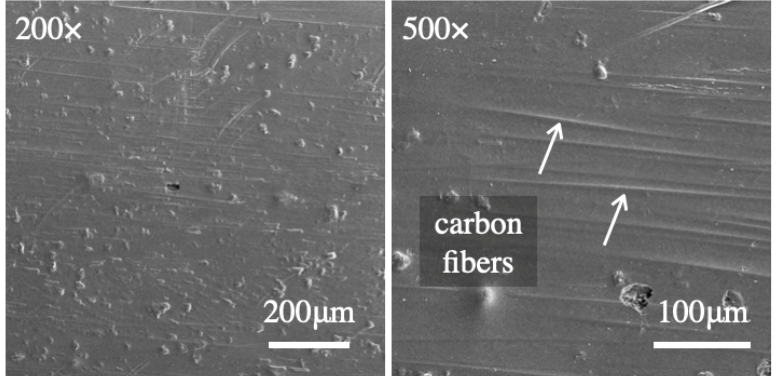
Figure 3. Scanning electron microscopy (SEM) images of the as-received CFRP surface after consolidation in the hot press. SEM images of grit-blasted (GB) CFRP surfaces are reported in Figure 4. The images indicate that the morphology and removal rate of the epoxy matrix are more sensitive to the gun-to-surface distance (D) rather than the number of passes (N). Indeed, by reducing D, more matrix was removed from the CFRP surface with a consequent increase of exposed carbon fibers.